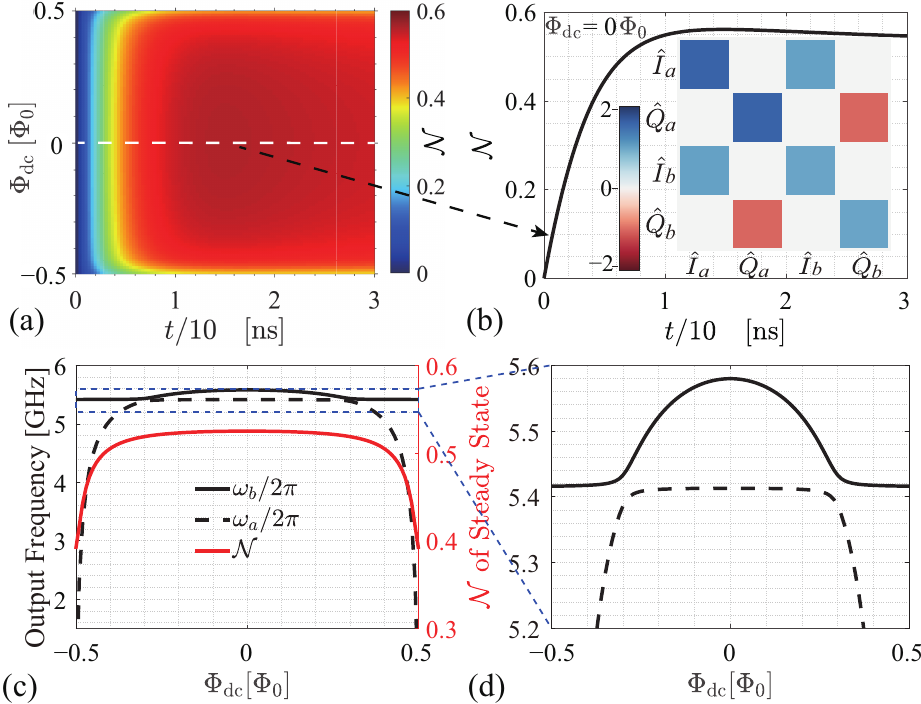
Figure 6. ( a ) Dependence of entanglement between the two modes N on the external dc flux bias Φ dc in the time domain. ( b ) N at Φ dc = 0 where g /2 π = 22.889 MHz is indicated by the white dashed line in ( a ). The inset is a visualization of covariance matrix V of the steady state at the selected dc flux bias. ( c ) Spectrum (left axis) and N of the steady state (right axis) of the entangled photons in one period. ( d ) The enlarged view of the blue dashed box in ( c